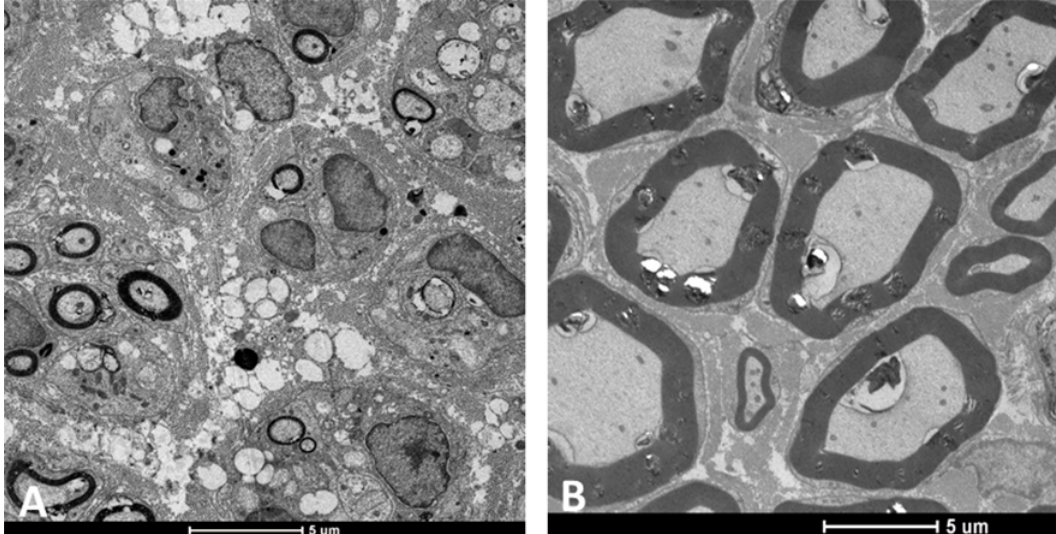
Figure 4. Distal stump fibers of the facial nerve of rats regenerating after end-to-end neurorrhaphy by fibrin biopolymer coaptation. Transmission electronic microscopy: (A) 5 weeks post-coaptation and (B) 10 weeks